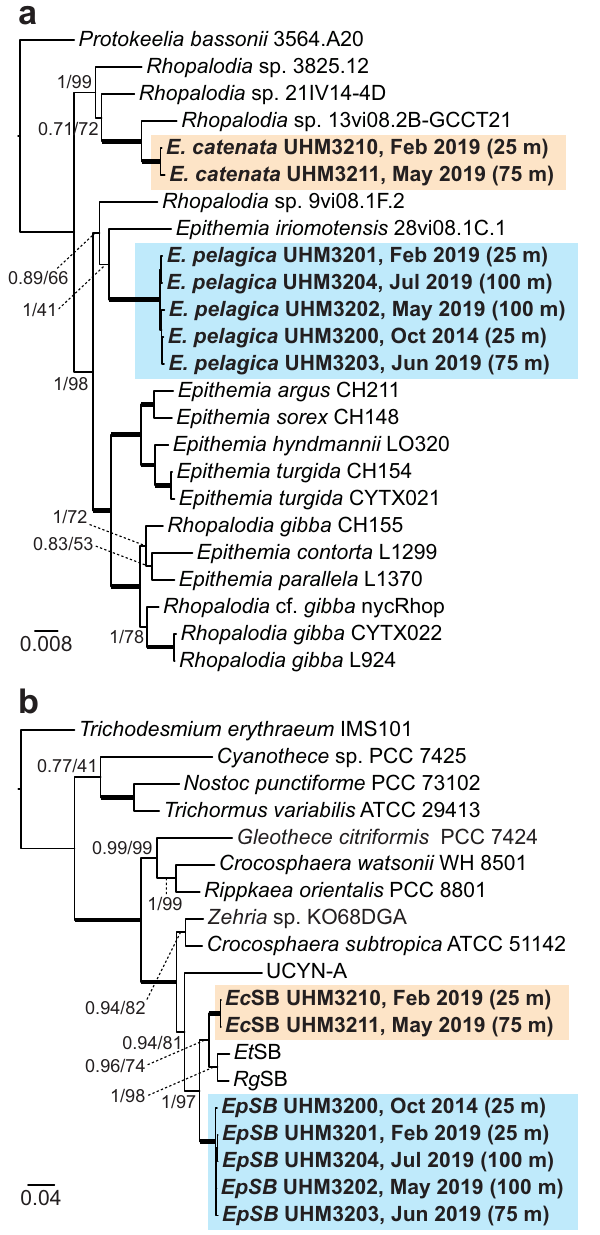
Figure 1a – c, n; Supplementary Figs. 1a – n, 2a – h, 6 – 10. Holotype . Slide UC2085162 from Epithemia pelagica UHM3201 deposited in the University and Jepson Herbaria at the University of California, Berkeley. Holotype specimen is illustrated in Sup-